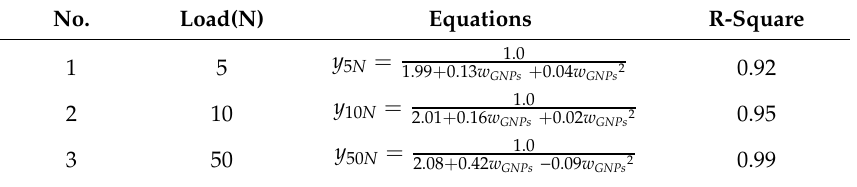
Figure 9. Variation of COF with varying GNPs content. Table 5. Regression equations of the COF versus WGNPs.